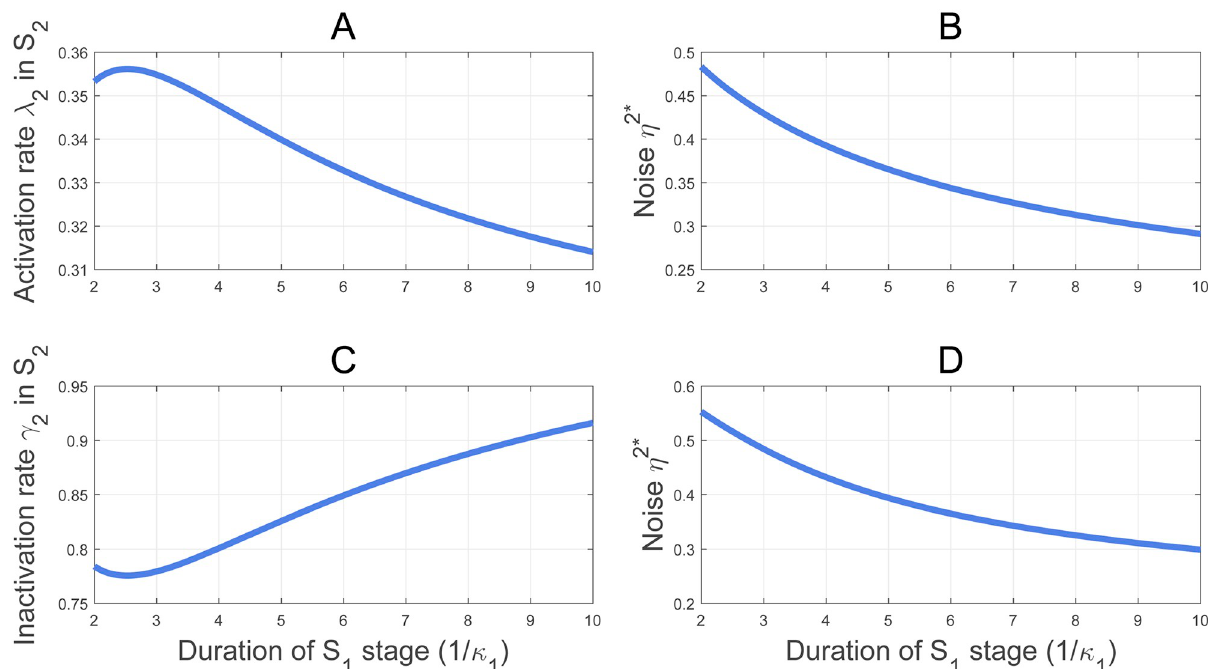
Fig 8. Minor variations of λ 2 , γ 2 and η 2 � versus the large variation of the cell cycle durations in the concentration homeostasis. (A) The transcription frequency for the concentration homeostasis stays within (0.315, 0.355) over a large span of the S k (cid:0) 1 ¼ 220 min , and other kinetic rates are taken from (58). (B) The noise corresponding to (A) remains within (0.28, 0.48). (C) The inactivation rate γ 2 2 for the concentration homeostasis with the parameters in (A) except λ 2 = λ 1 /2 to equalize the burst frequency in S to (C) remains within (0.29,